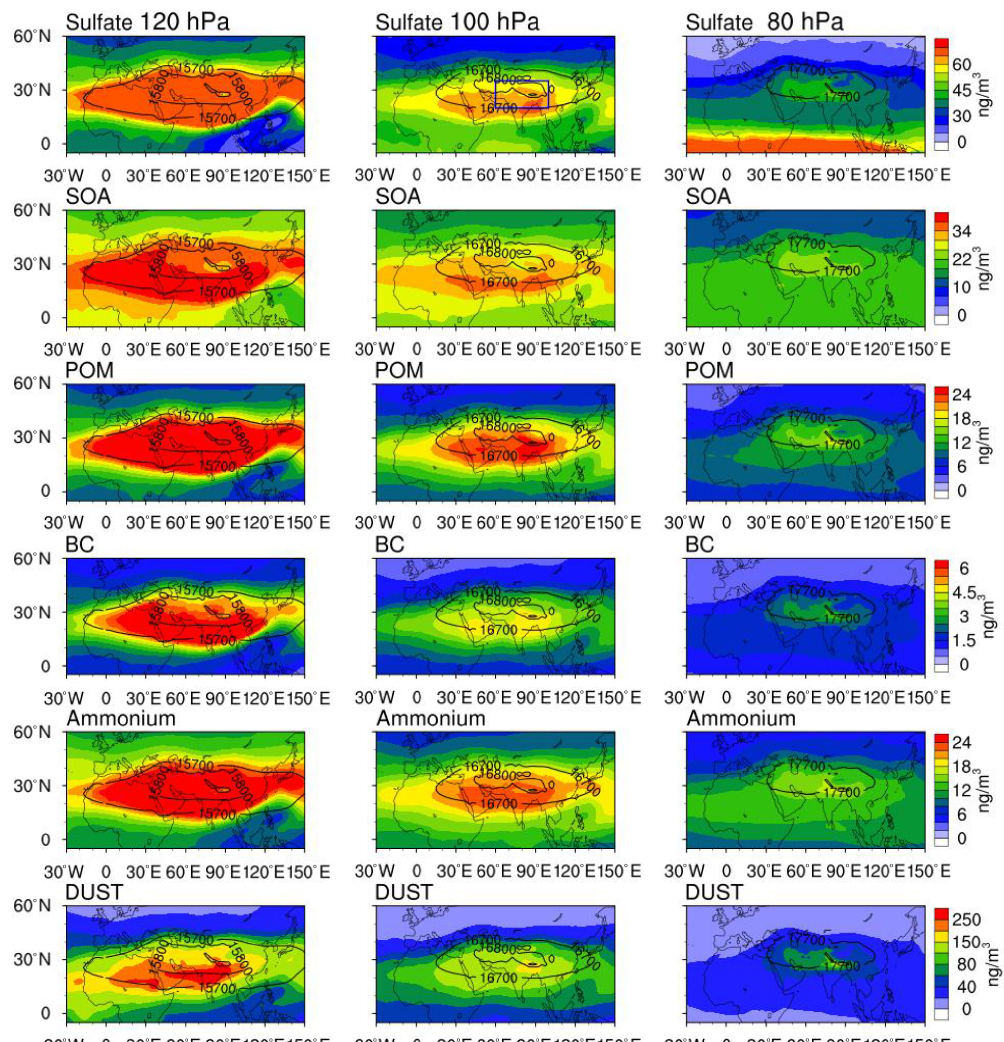
Figure 2. Spatial distribution of the aerosol mass concentration, averaged over July–August 2014, from CESM-MAM7 simulations, for six different aerosol types. From top to bottom row: sulfate, SOA, POM, BC, ammonium (in the accumulation mode) and mineral dust (in the fine dust soil mode). From left to right column: 120, 100 and 80hPa pressure levels. Note the different color-scale ranges. The black lines in the map represent the geopotential height > 15700m at 120hPa, > 16700m at 100hPa and > 17700m at 80hPa. The blue box (second panel) represents the area chosen for the subsequent ATAL-specialized analyses (20–35 ◦ N, 60–100 ◦